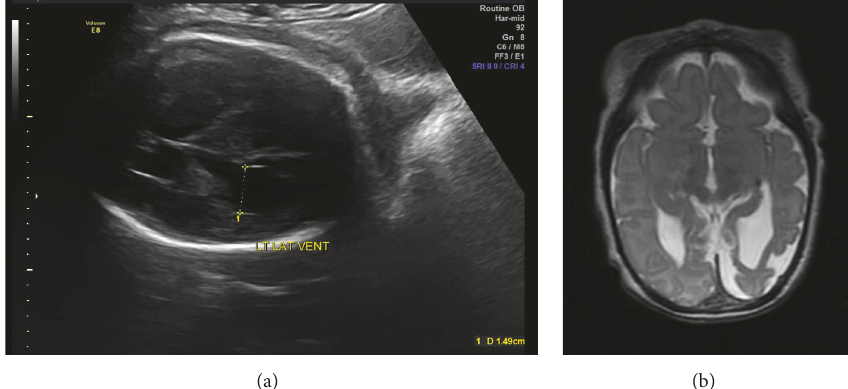
Figure 2: Fetal intracranial imaging and postnatal follow-up. (a) Ultrasound at 35-week gestation demonstrates unilateral ventriculomegaly. (b) MRI at day 4 of life shows cystic encephalomalacia of the bilateral frontal and left parietal lobes and artifact consistent with a previous intraventricular hemorrhage, hemorrhagic contusion, and subdural hematoma.